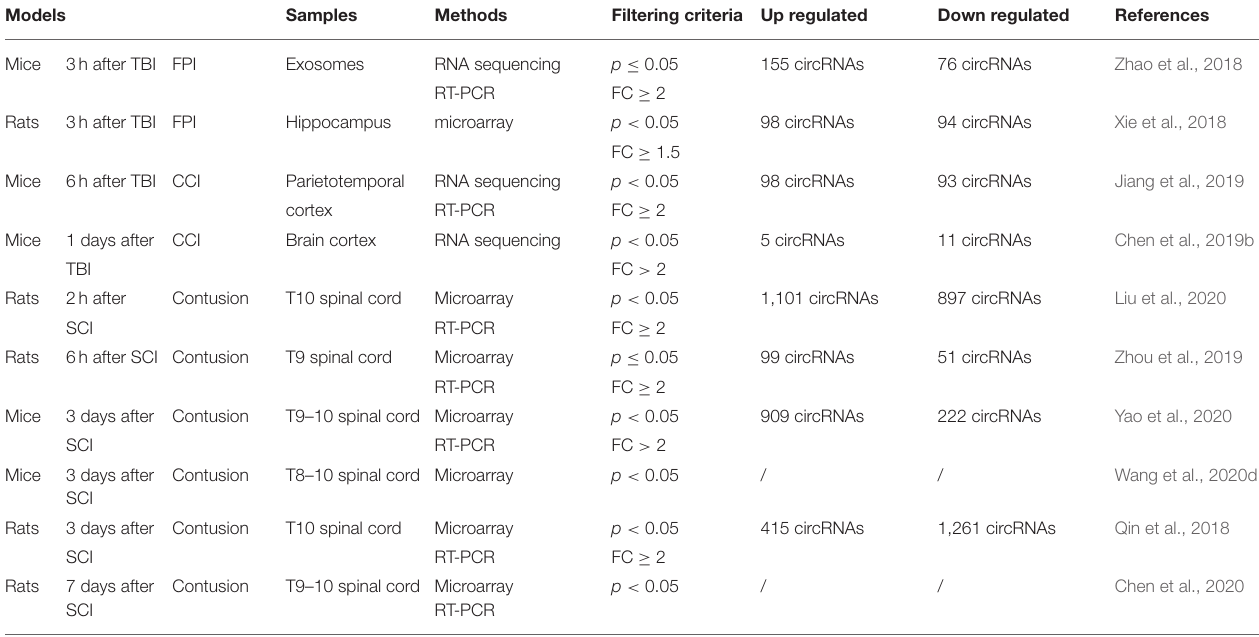
TABLE 1 | Circular RNA (circRNA) expression profiles in CNS post-traumatic